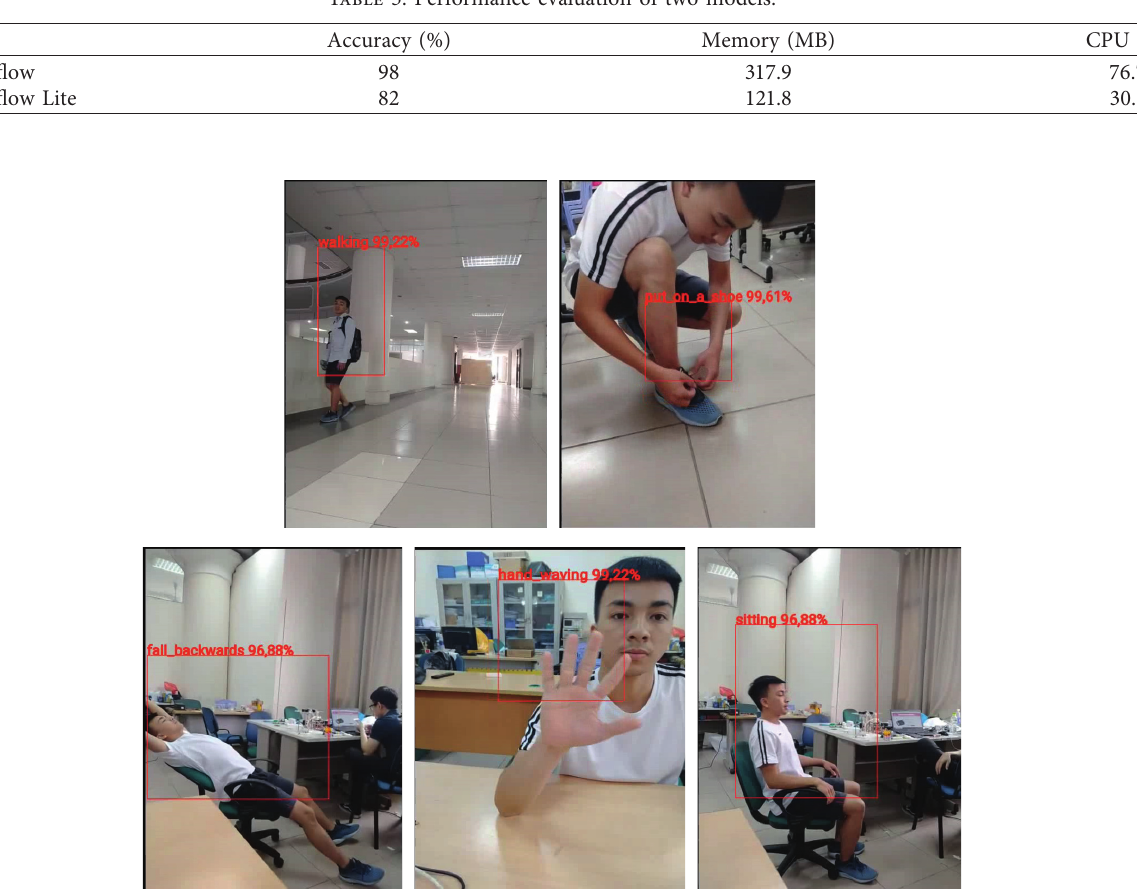
Figure 21: Result of the model with our